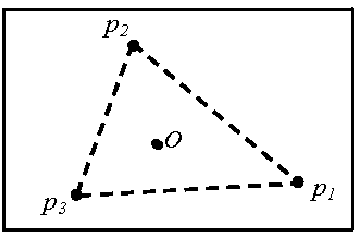
Figure 4. Initial frontier.